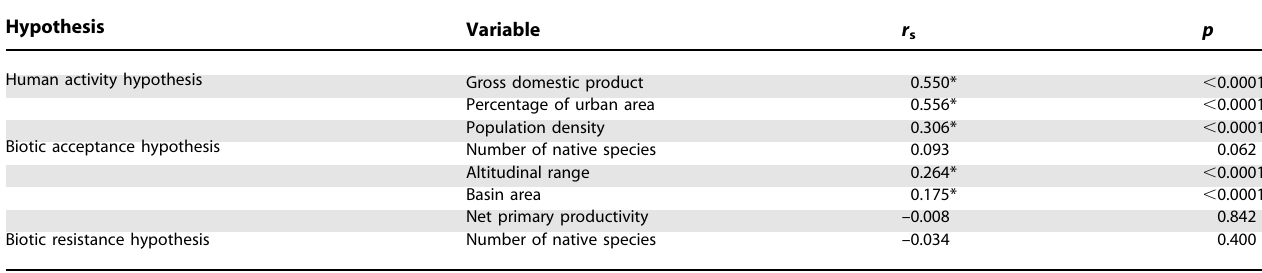
Table 1. Spearman Rank Correlation ( r s ) between the Number of Non-Native Fish Species (Residuals) and Each Explanatory Variable Related to the ‘‘ Human Activity, ’’ ‘‘ Biotic Acceptance, ’’ and ‘‘ Biotic Resistance ’’ Hypotheses ( n ¼ 597) Hypothesis